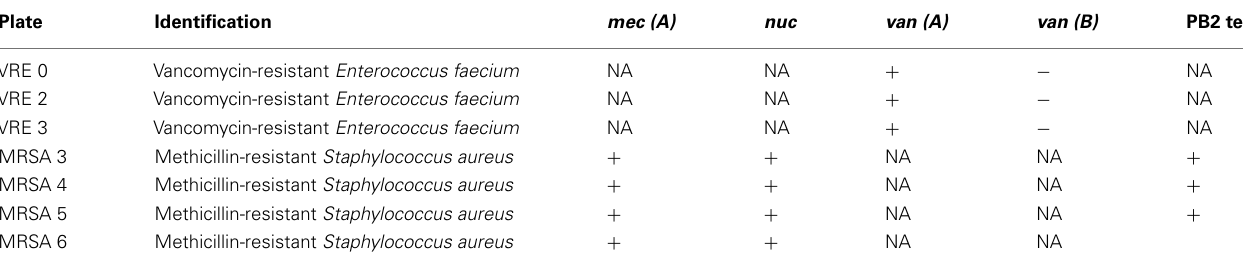
Table 3 | Identification of clinical isolates and confirmation of antibiotic